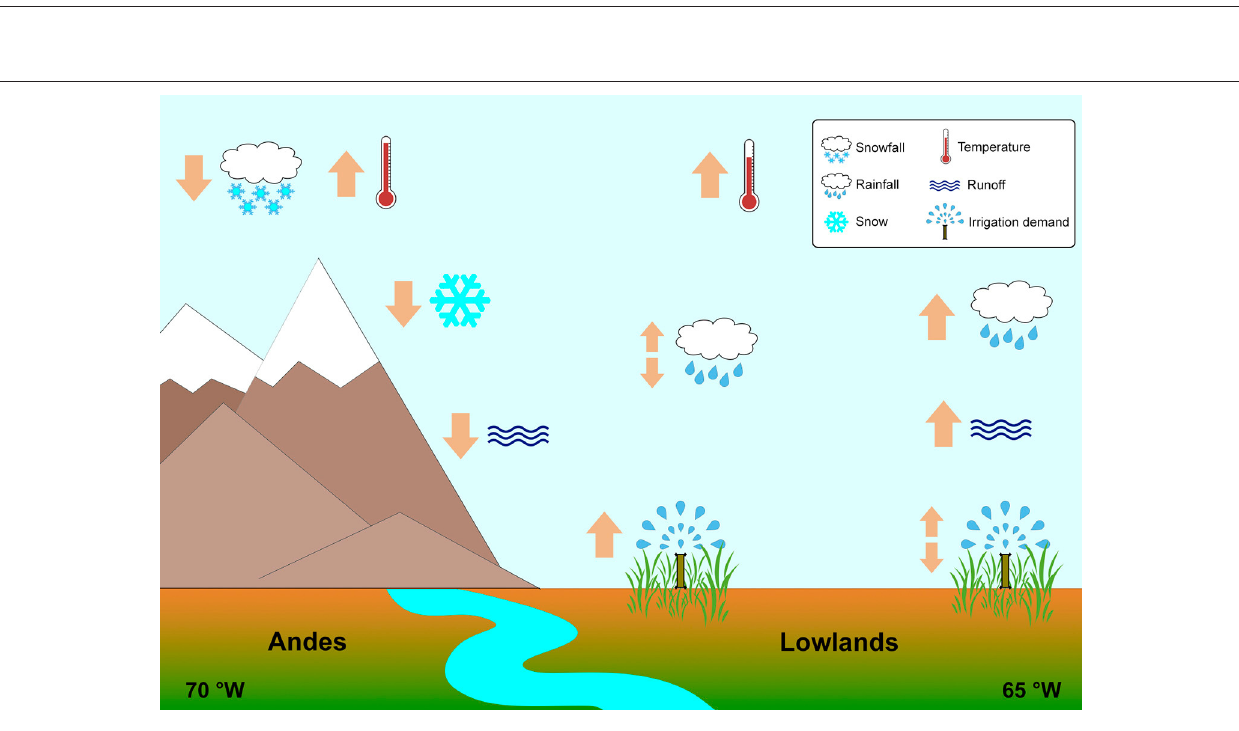
FIGURE 10 | Conceptual diagram summarizing the expected changes in the hydroclimate of the CWA. Upward and downward arrows show positive and negative changes in the water cycle components for the selected warming levels, respectively. The combination of upward and downward arrows reflects the uncertainty in the expected